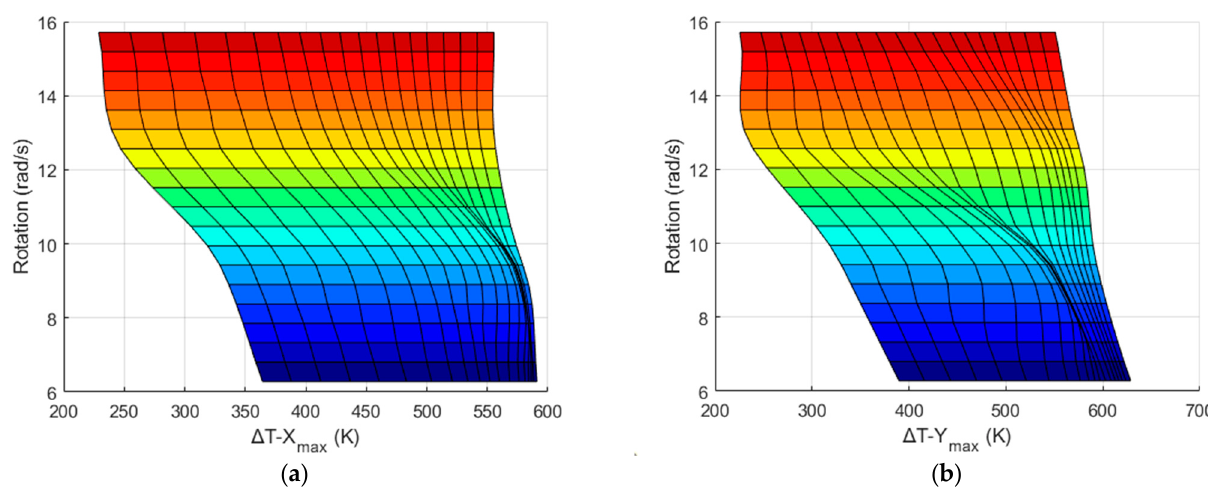
Figure 21. ω w.r.t Δ T x ( a ) and Δ T y ( b ).